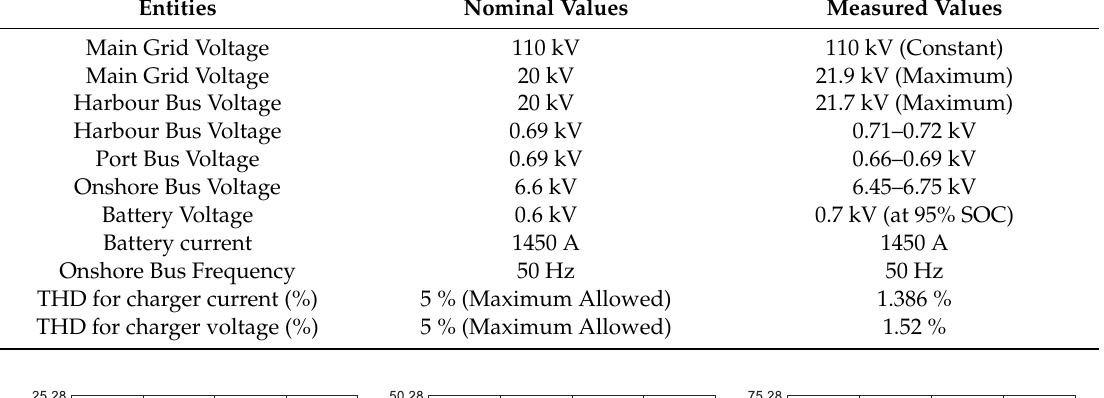
Table 3. Simulation results of Configuration D: Fast charging of onboard batteries and cold-ironing from the same onshore AC power supply.